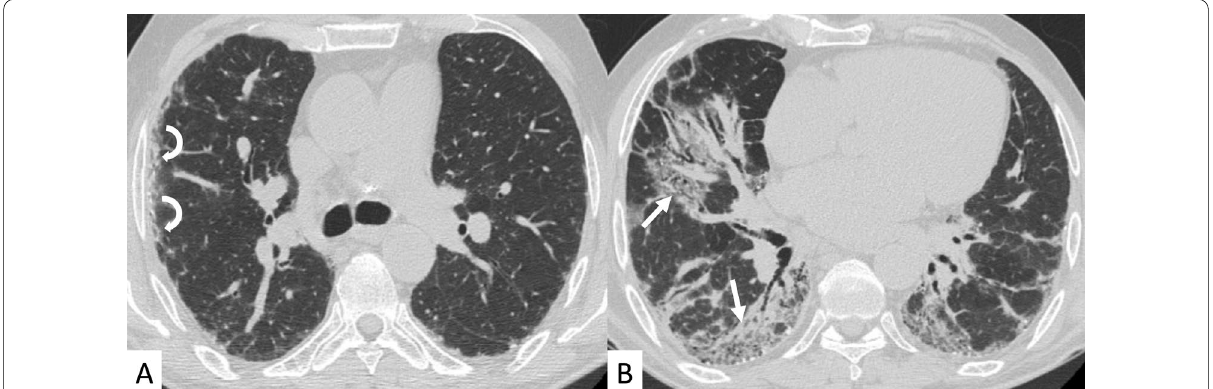
Fig. 15 NSIP pattern in a patient with PM. Subpleural reticulations are located in the subpleural regions, namely located in the right lung (white curved arrows in A . Ground-glass opacifications and reticulations are demonstrated through the lung, predominantly located in the basal right lung and in the middle lobe (white arrows in B ), with small bronchiectasis included